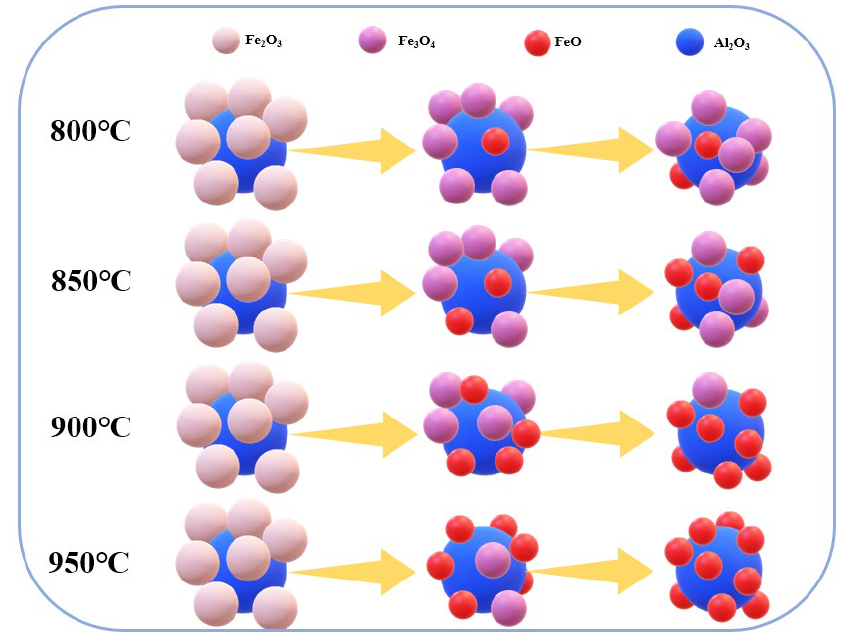
Figure 7. Schematic diagram of activated molecules becoming more due to temperature rise.